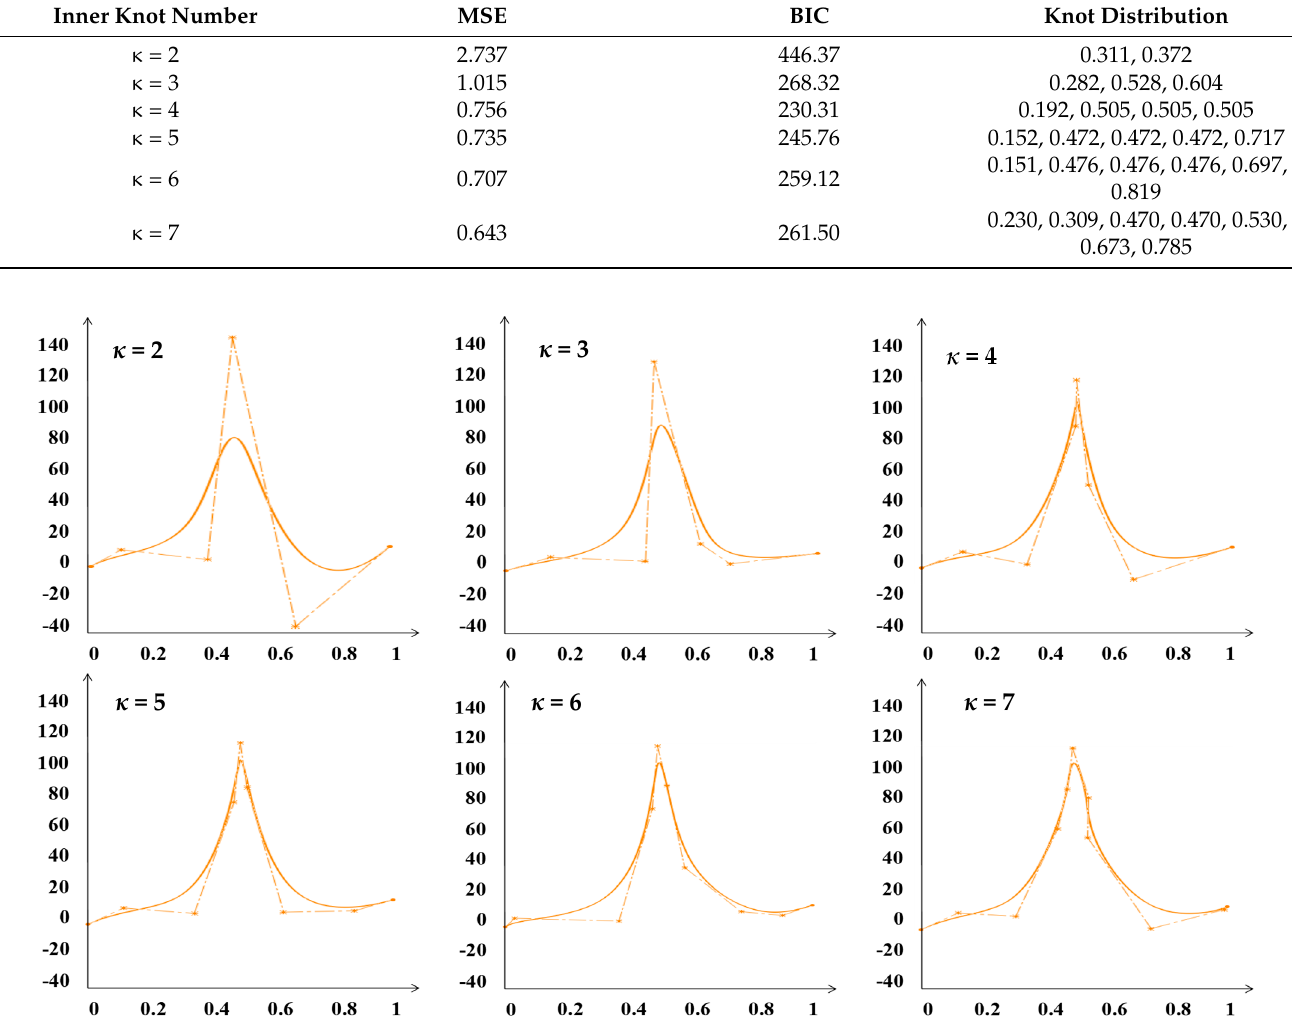
Figure 15. Fitting results of different number of